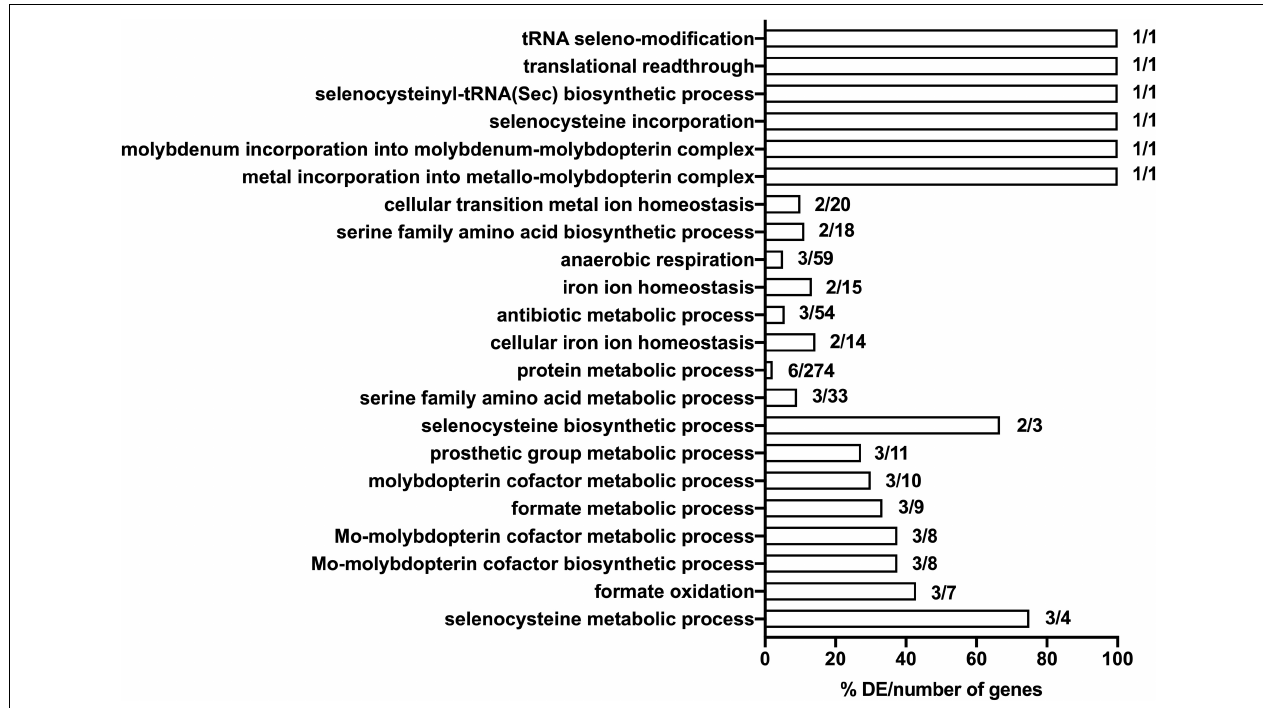
FIGURE 5 | Significantly enriched gene ontology (GO) terms for the seventeen mutants that show significant loss of fitness following 30- and 90-min exposure to model honey. Genes included in the analysis were these whose corresponding mutants had a logFC > 1 or < –1 with adjusted p -values < 0.005. Comparisons were made using the number of genes associated with each term in the gene set versus the total number of genes associated with each term in the ( E. coli MG1655) genome. The respective percentage is given in x